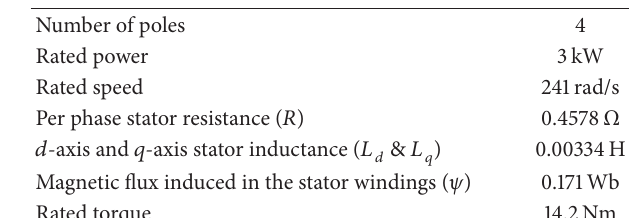
Table 1: Parameters of